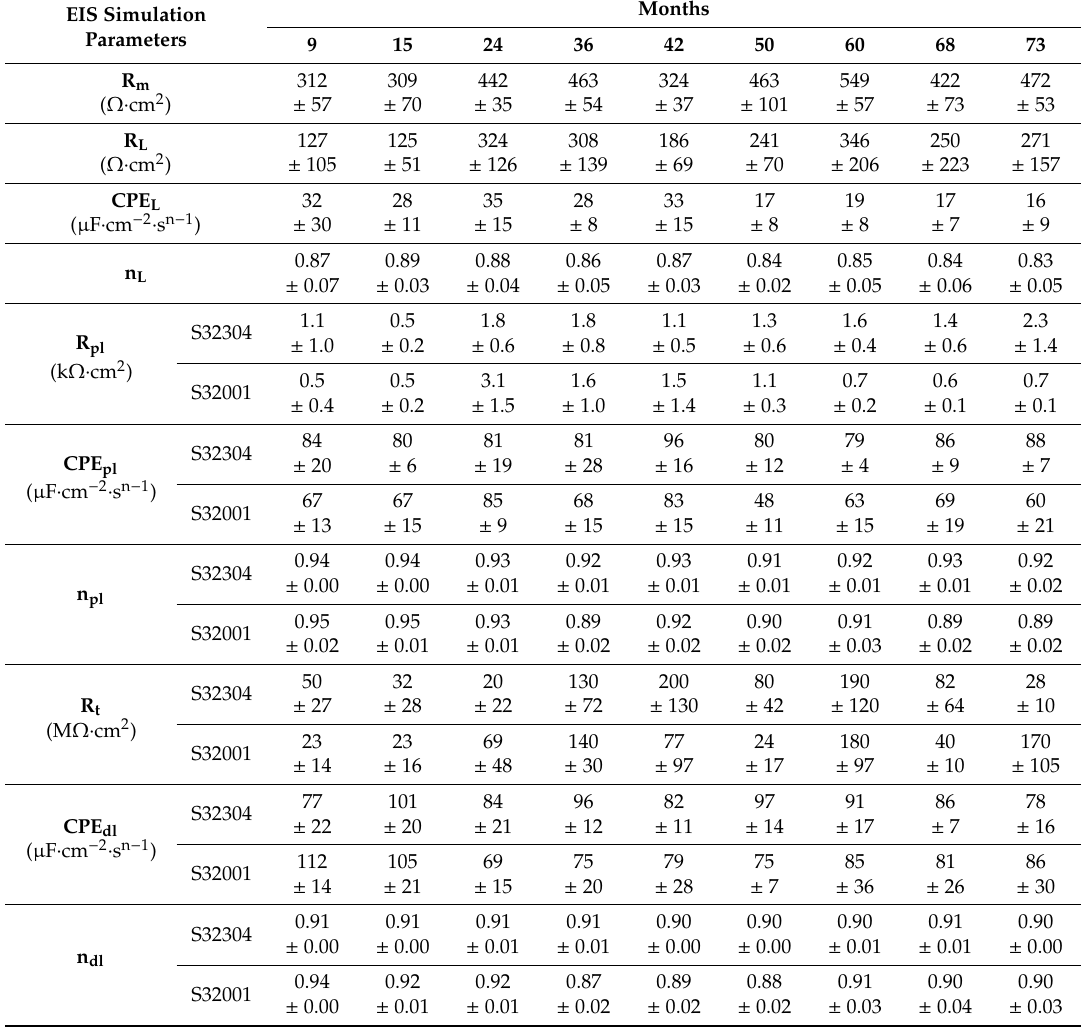
Table6. ResultsfromsimulationsoftheEISspectraofreinforcedsamplestestedunderHH-PCcondition.